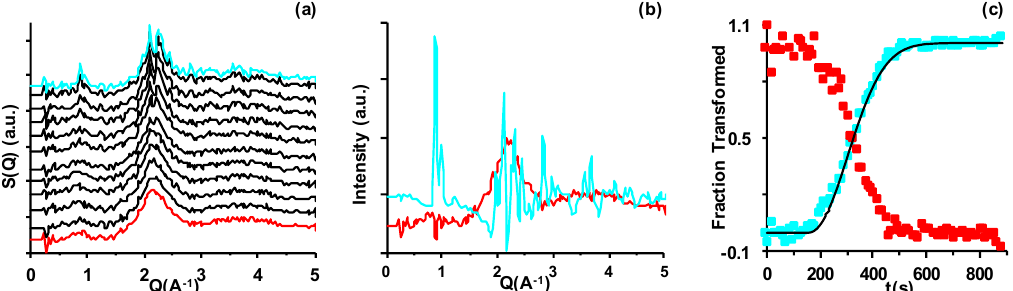
Figure 3. TtND of the crystallization of [Zn(OH 2 ) 6 ][ZnCl 4 ] for a T iso = 238 K experiment. ( a ) Stack plot of the time dependent diffraction patterns (22 s intervals); ( b ) Time-independent basis vectors corresponding to the liquid (red) and crystalline (cyan) diffraction patterns; ( c ) Time-dependent basis vectors demonstrating the disappearance of liquid diffraction (red) and appearance of crystalline (cyan) diffraction, fit to the KJMA model (black line).